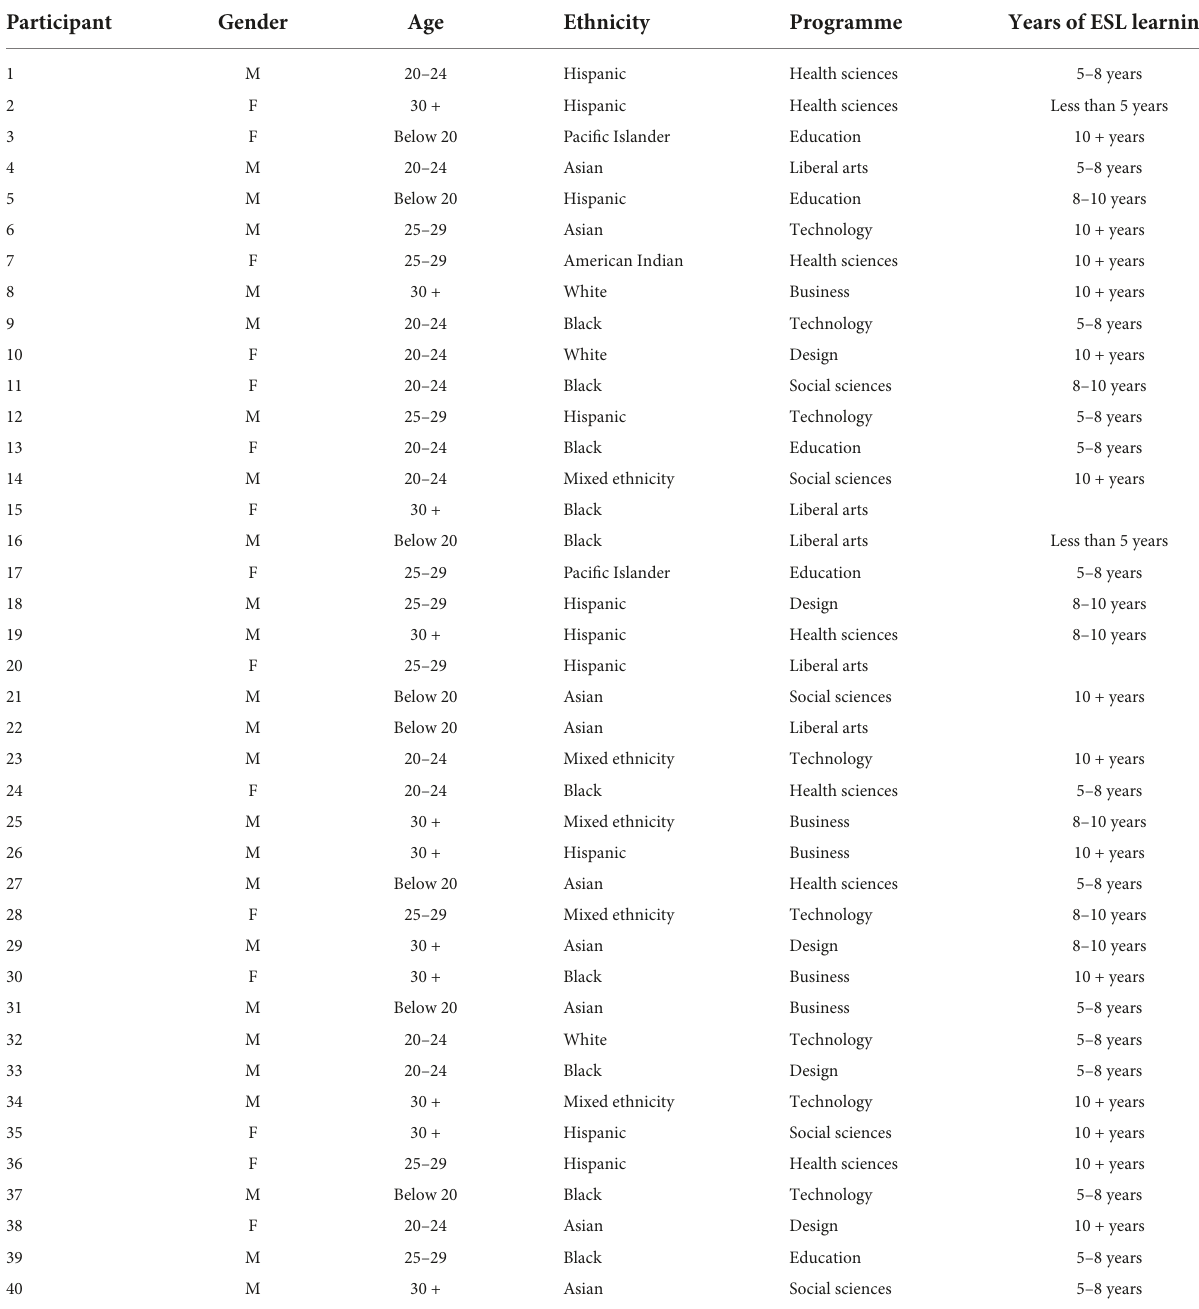
TABLE 1 Detailed demography of the